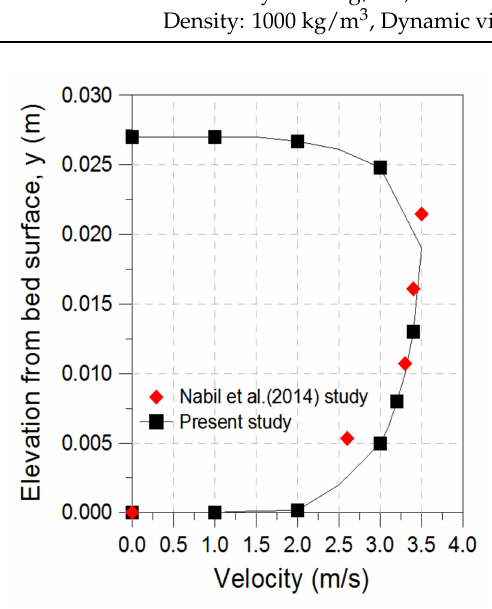
Figure 3. Comparison of the velocity of the simulated mixture (m/s) with that in experimental results [7].